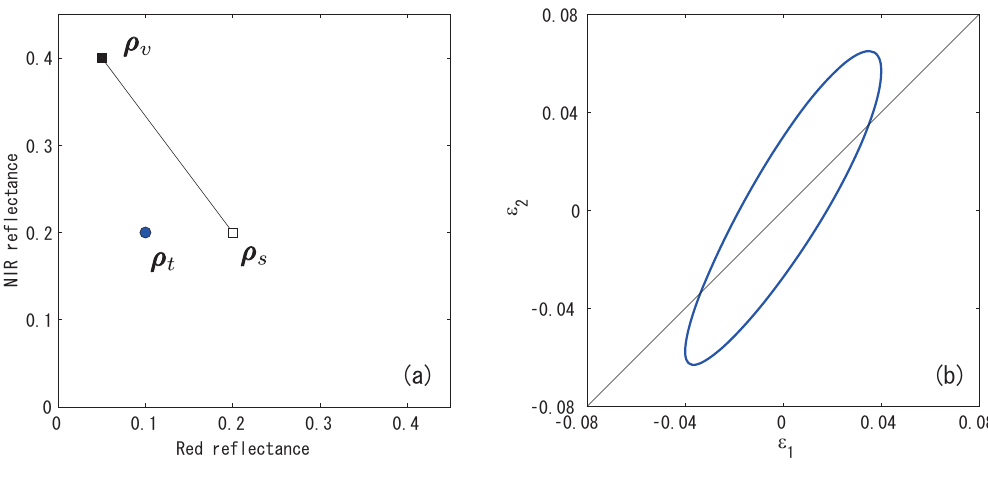
Figure 2. An example of the relationship between (cid:15) simulations. ( a ) shows the target spectrum (0.1,0.2), the vegetation spectrum (0.05,0.4), and the non-vegetation endmember spectrum (0.2,0.2), indicated by the blue dot, the filled and empty squares, respectively. The magnitude of the input error is set to 0.01. NDVI is used as the endmember model in algorithm-2. In ( b ), the ellipse is obtained by varying θ in Equations (7) and